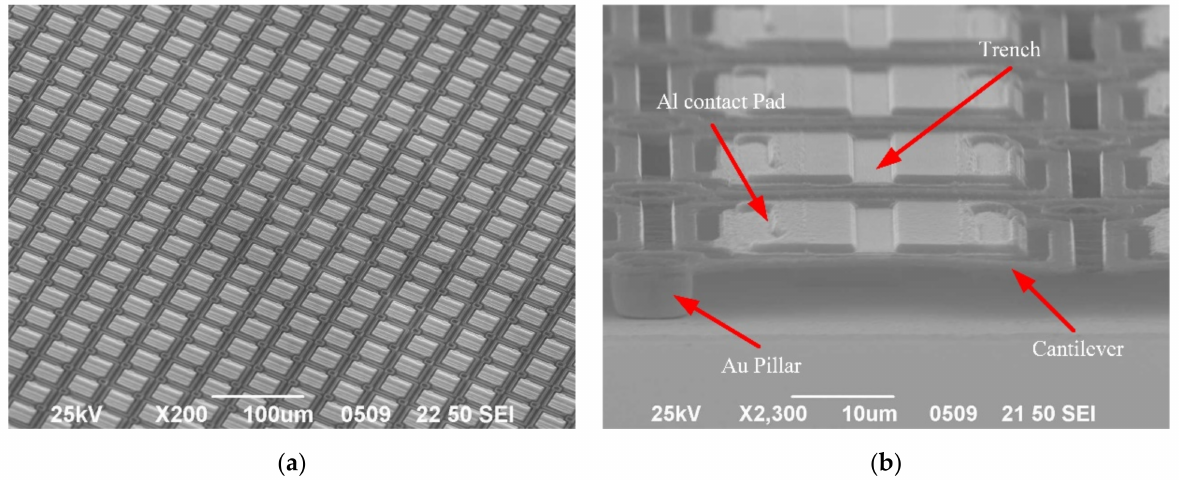
Figure 6. ( a ) The SEM graph of the partial micro-bolometer array; ( b ) The SEM graph of several L-type pixels of the micro-bolometer